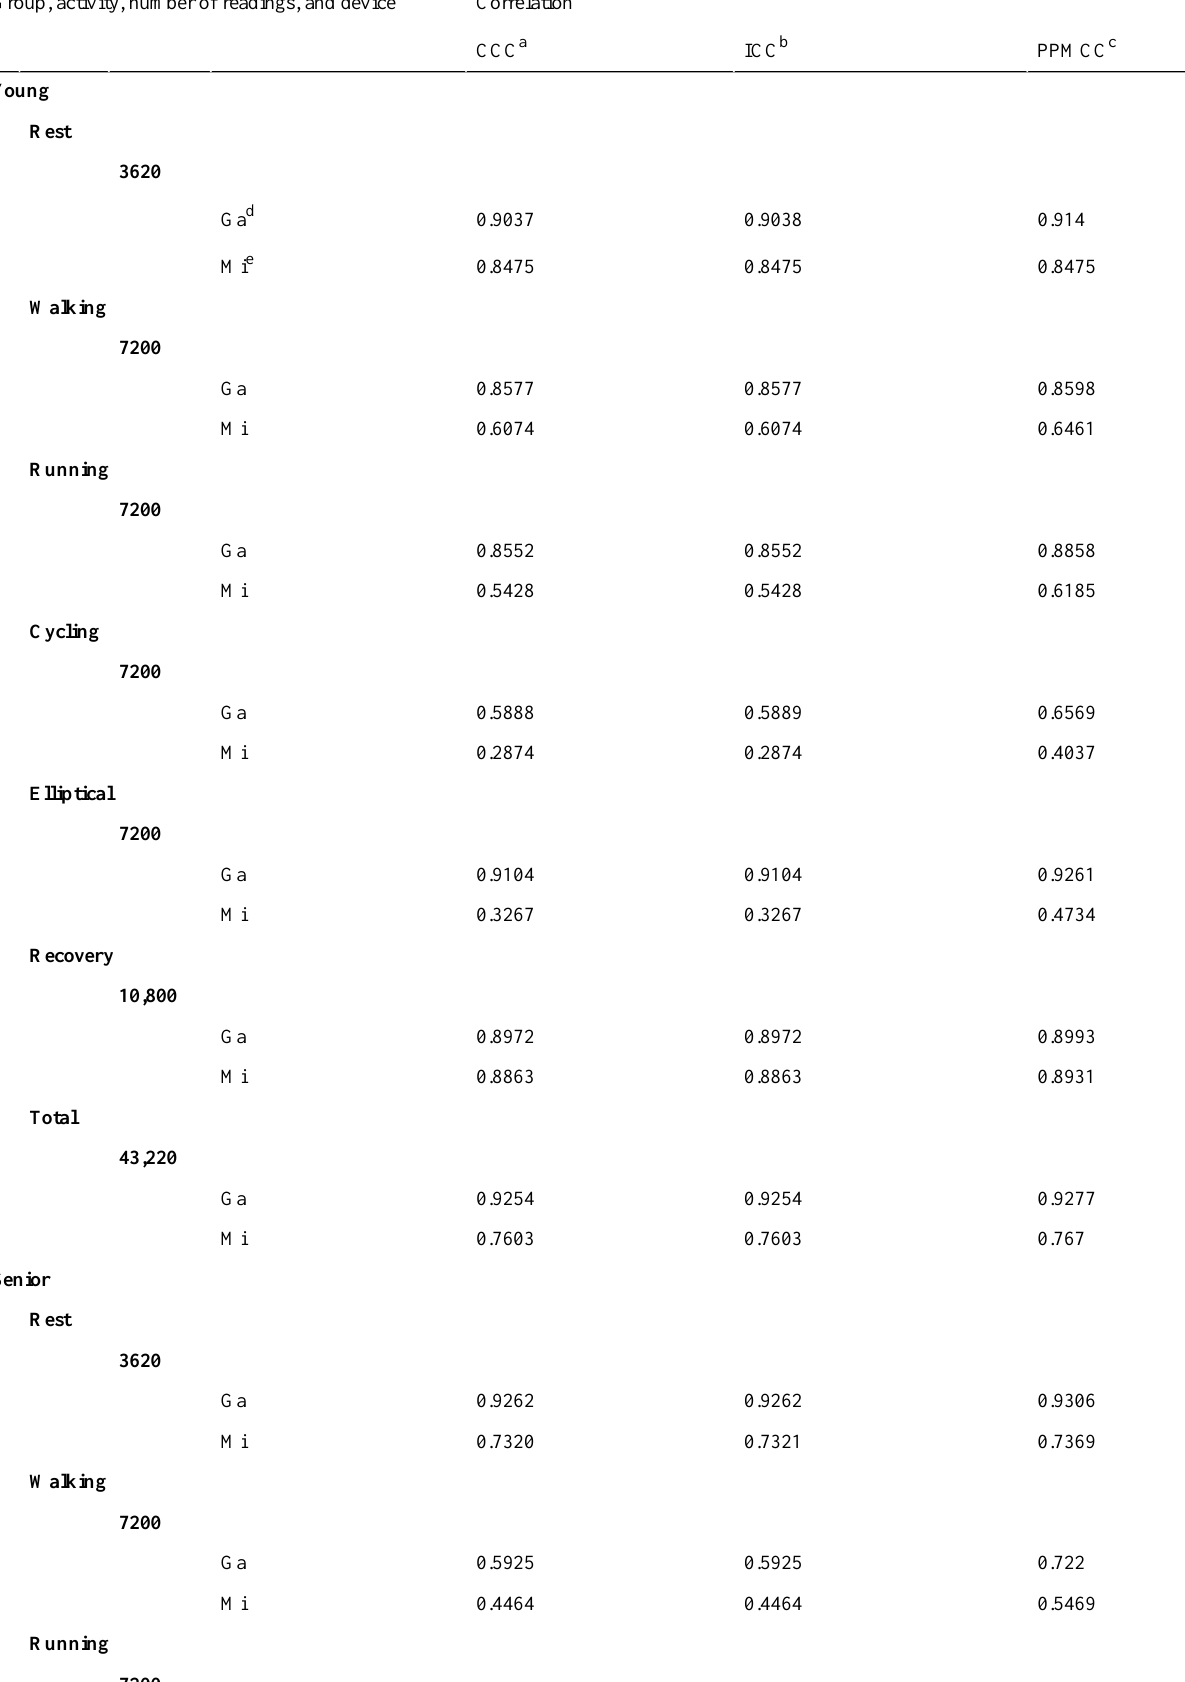
Table 2. Correlation analyses of heart rate readings of Young and Senior groups during different activity phases. CorrelationGroup, activity, number of readings, and